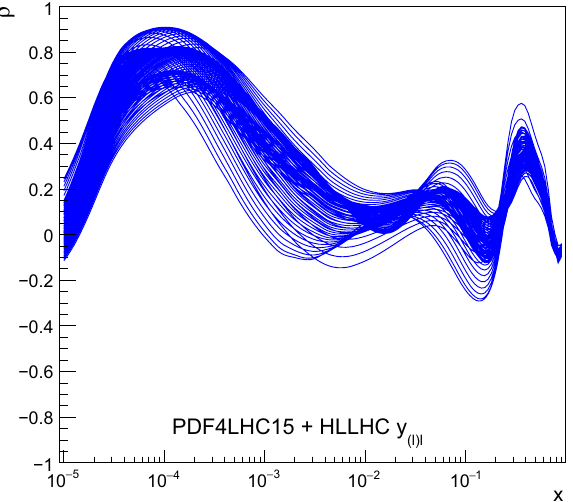
sive W , Z production process in the forward region. In each plot, the different curves correspond to each of the bins of the pseudo–data used in the fit